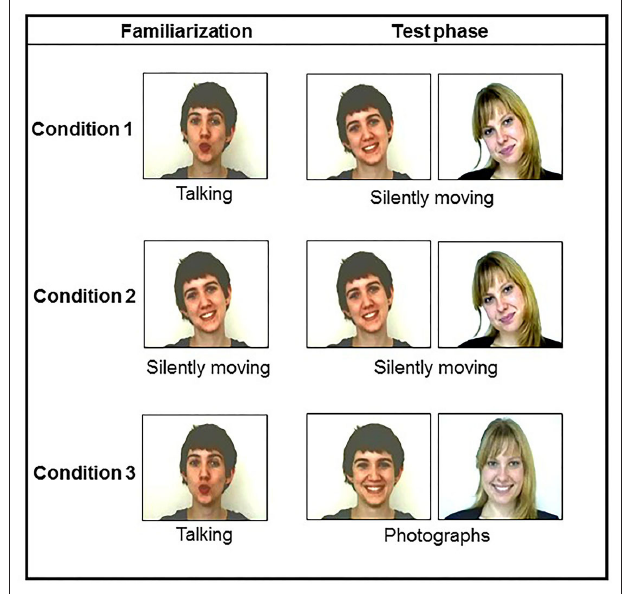
FIGURE 2 | Examples of the stimuli presented for each